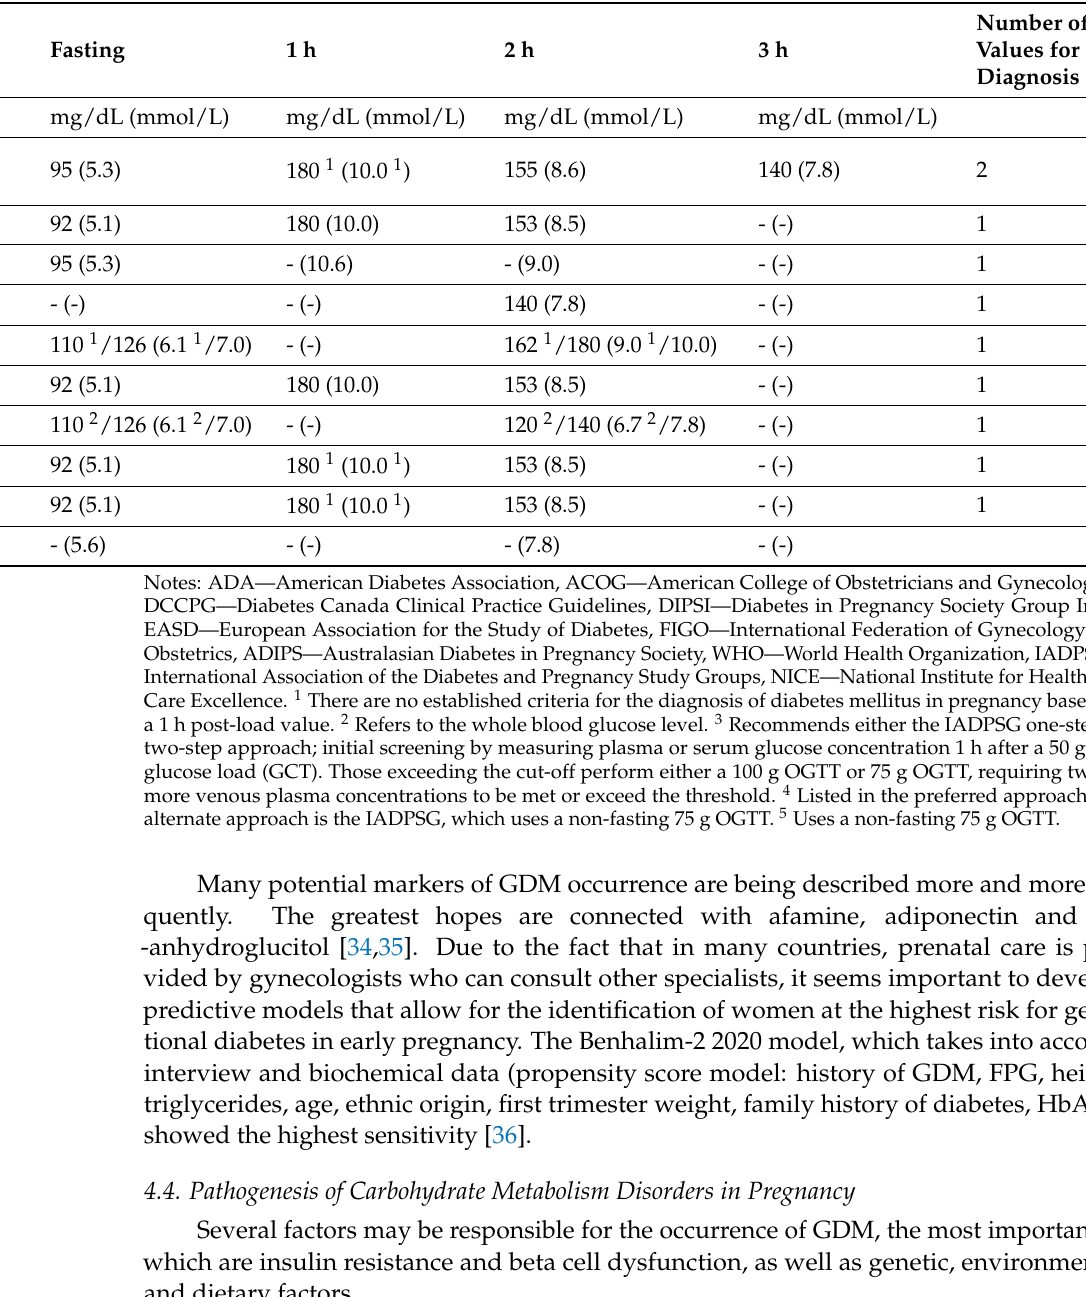
Table 2. The criteria for the diagnosis of GDM according to different scientific